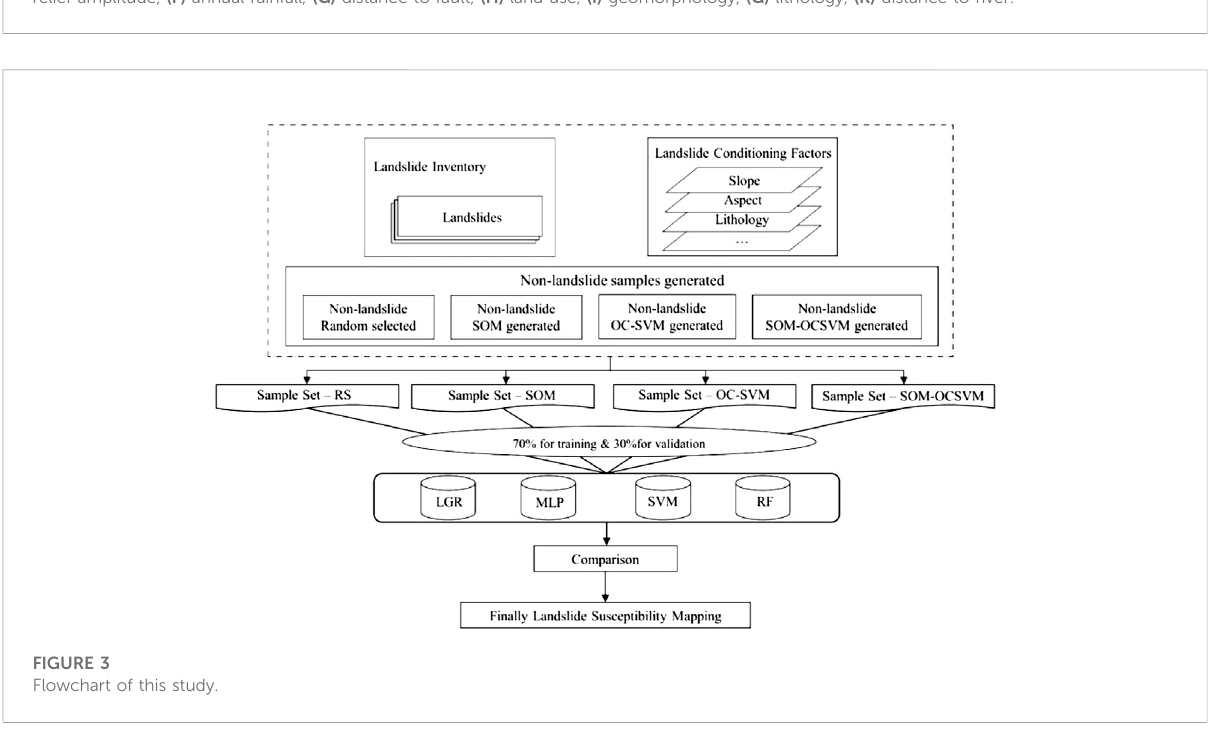
FIGURE 3 Flowchart of this